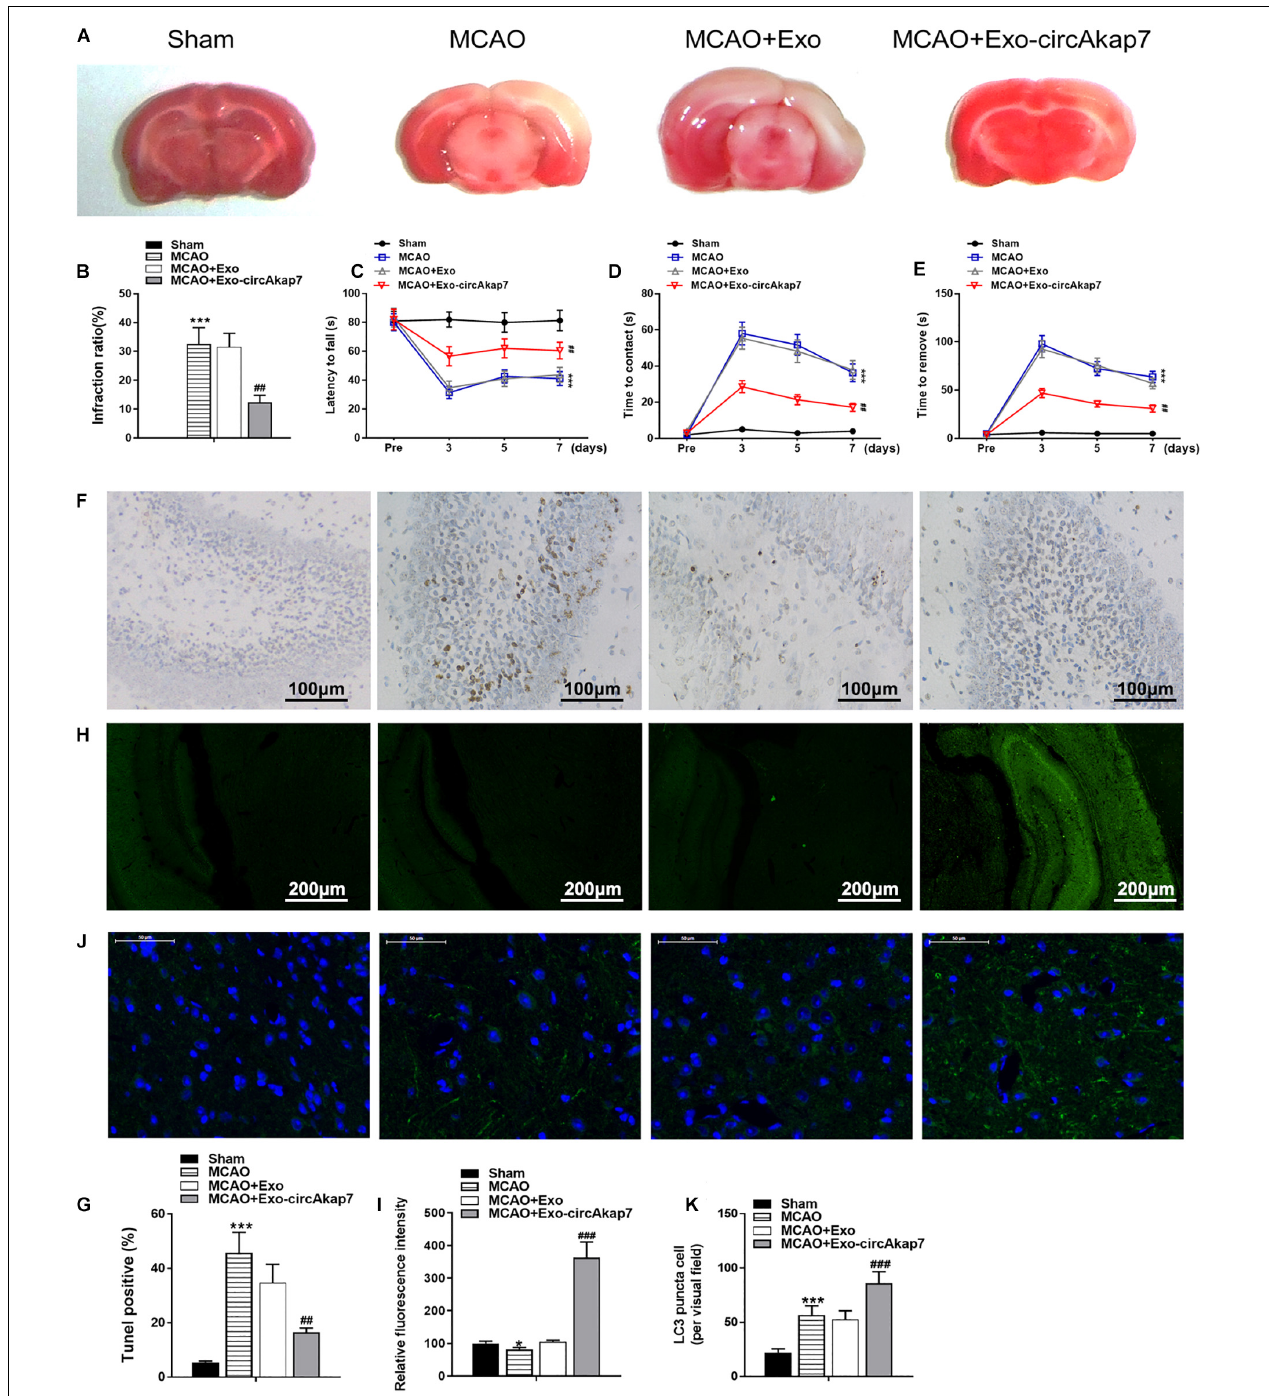
FIGURE 3 | Treatment with ADSC-derived circAkap7-enriched exosomes ameliorates cerebral ischemic injury in a mouse model of tMCAO. (A,B) Images showing representative TTC staining. The infarct size was measured and calculated as a percentage of the total area. (C) Rotarod test. (D,E) Adhesive removal test. Data are expressed as latency to contact (D) and tape removal from the impaired forepaw. (F,G) The quantified level of apoptosis in cortex around infarct regions was measured by TUNEL assays. The groups were, from left to right: Sham, MCAO, MCAO+Exo, MCAO+Exo-circAkap7. (H,I) Quantified fluorescence intensity from FISH assays, conducted to determine the subcellular localization of circAkap7 in in cortex around infarct regions. The groups were, from left to right: Sham, MCAO, MCAO+Exo, MCAO+Exo-circAkap7. (J,K) A representative image of LC3 puncta (green) staining in cortex around infarct regions. Nuclei were counterstained with DAPI (blue). The groups were, from left to right: Sham, MCAO, MCAO+Exo, MCAO+Exo-circAkap7.Cells with LC3-positive puncta were quantified, and are expressed as the mean ± SEM, n = 8 mice. * p < 0.05, *** p < 0.001 vs. sham, ## p < 0.01, ### p < 0.001 vs. tMCAO.